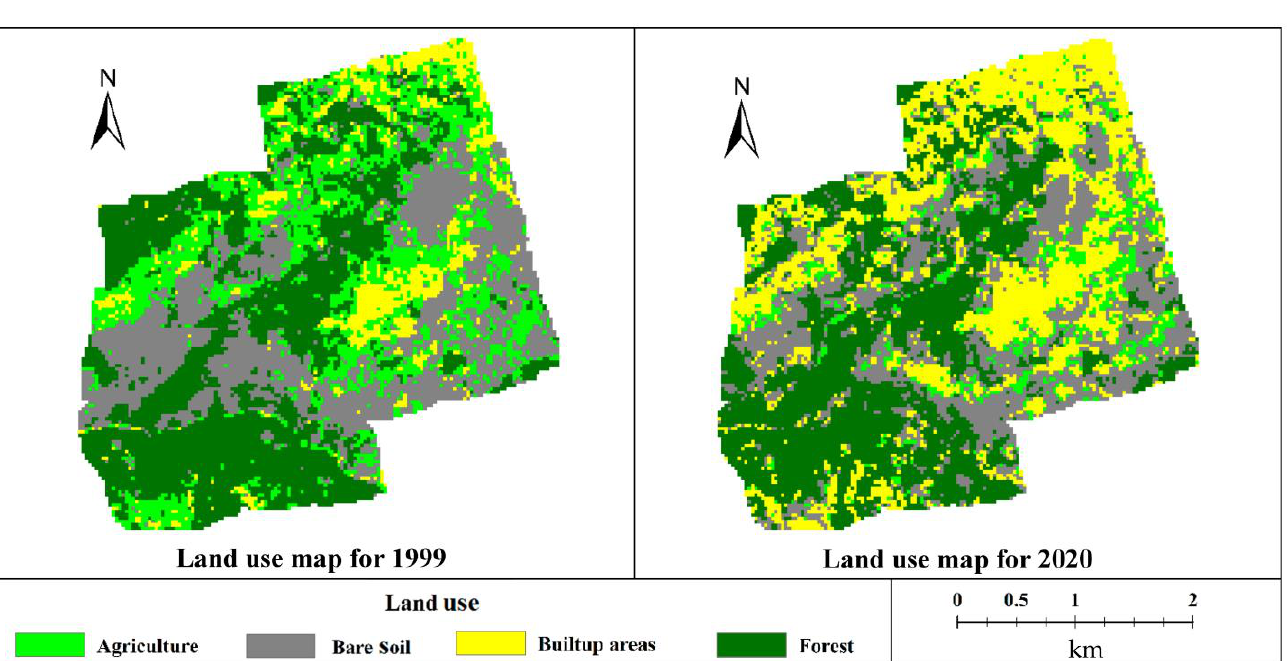
Figure 2. Land use maps of the study area for the years 1999 and